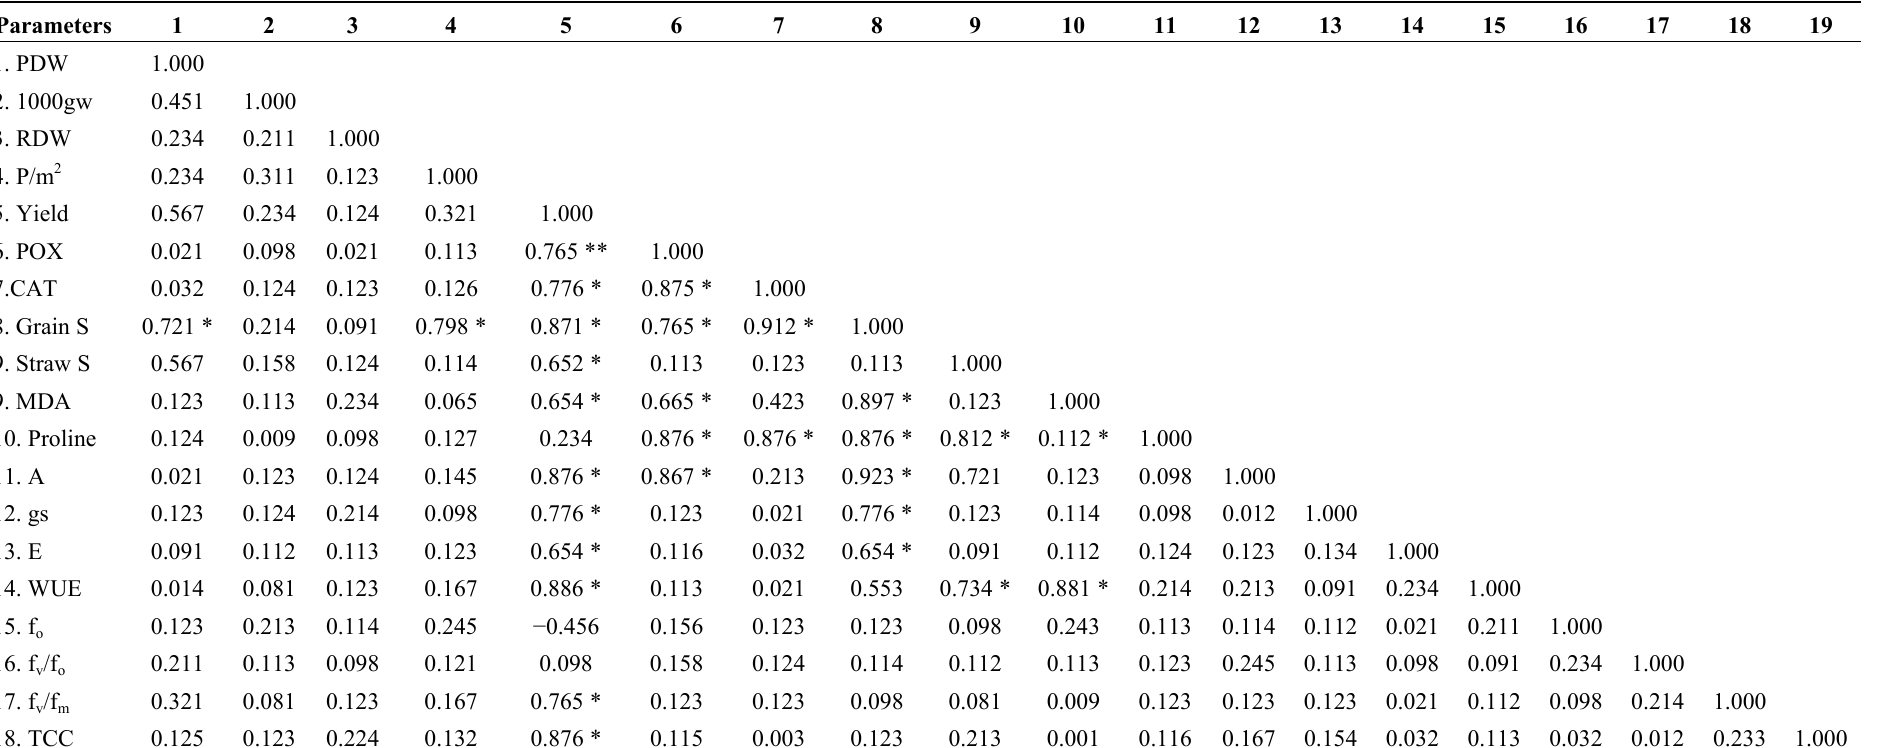
Table 2. Pearson’s correlation coefficients between all